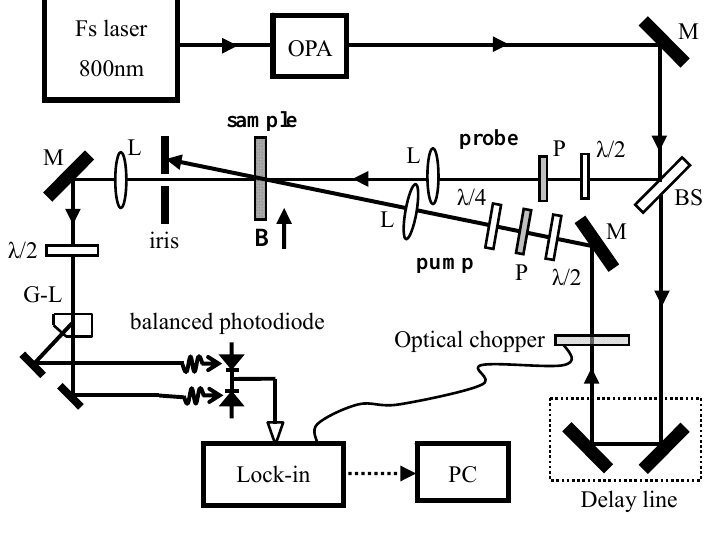
Figure 2. Experimental scheme for time-resolved Faraday rotation